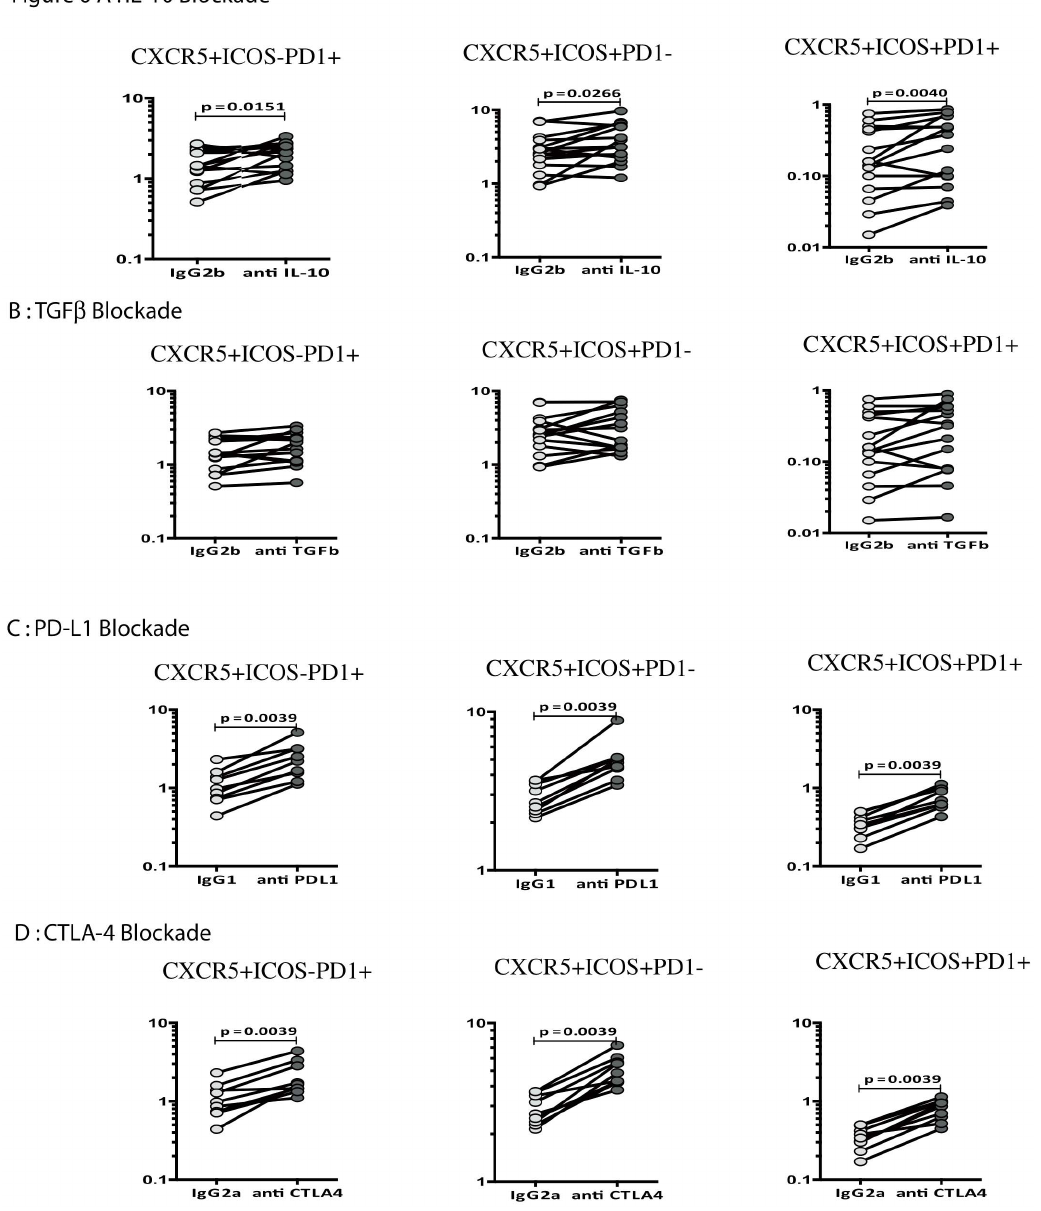
Figure 6. Blockade of IL-10, CTLA-4 and PD-L1 but not TGF b significantly enhances Tfh cell subset frequencies in PTB. Whole blood from PTB individuals was stimulated with PPD in the presence of anti-IL-10 Ab (A) or anti-TGF b Ab (B) or isotype control antibodies and in the presence of anti- CTLA-Ig (C) or anti-PD-L1 (D) or isotype control antibody for 18 h and the frequencies of CD4 + CXCR5 + PD-1 + , ICOS 2 ; CD4 + CXCR5 + PD-1 2 ICOS + and CD4 + CXCR5 + PD-1 + ICOS + T cells were estimated by flow cytometry. Results are shown as line diagrams with each line representing a single individual. P values were calculated using the Wilcoxon signed rank test.